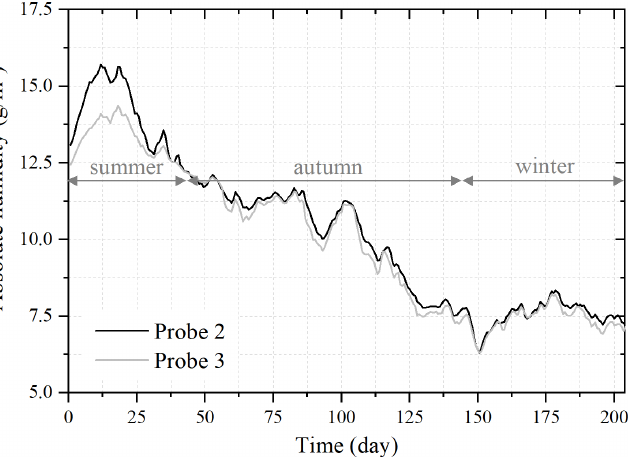
Figure 13. Evolution of absolute humidity in the ventilated air space: Probes 2 and 3 are fixed at the bottom and the top of the air space,